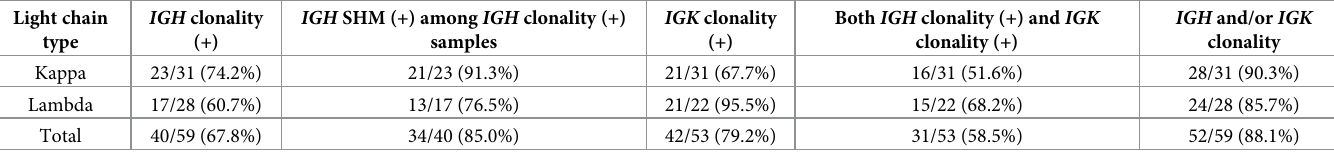
Table 2. IGH clonality, IGH somatic hypermutation, and IGK clonality according to light chain types in 59 bone marrow samples from 57 Korean patients with multiple myeloma. Light chain IGH clonality type